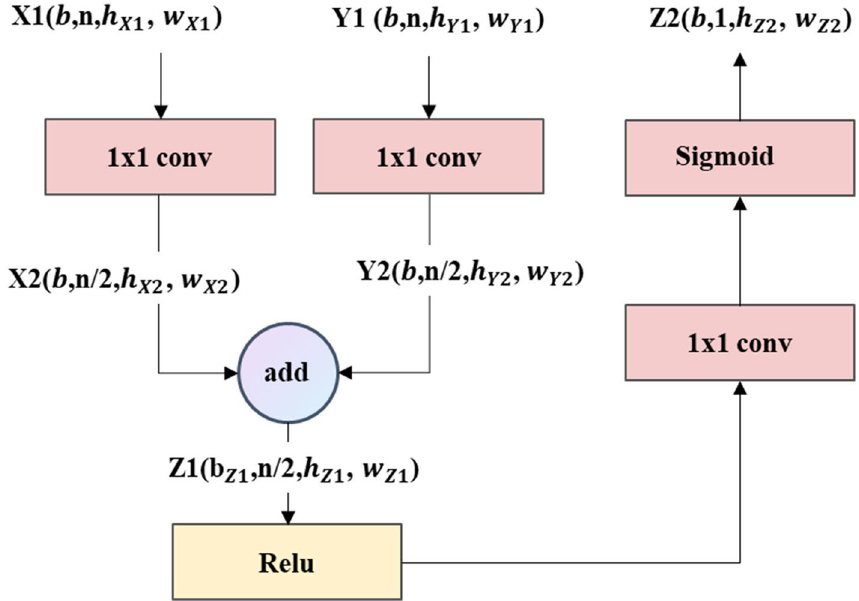
Figure 6. Attention Convolution module